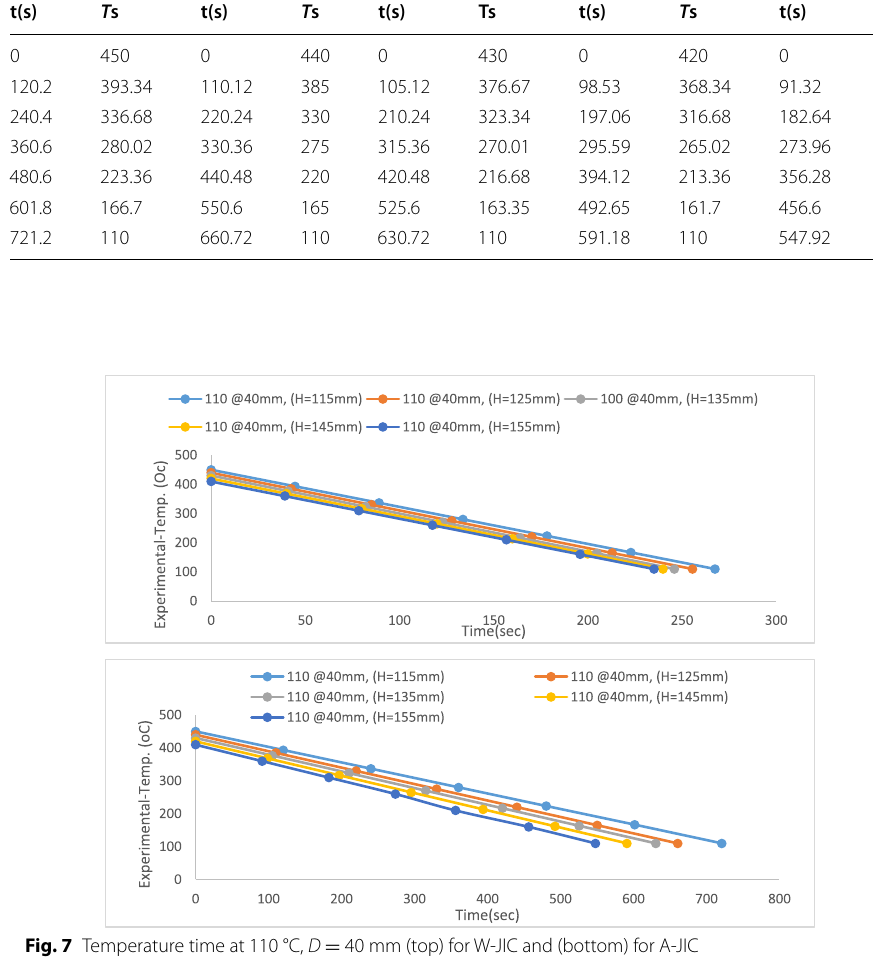
Table 5 110 °C at D T 450 at D = mm ( H